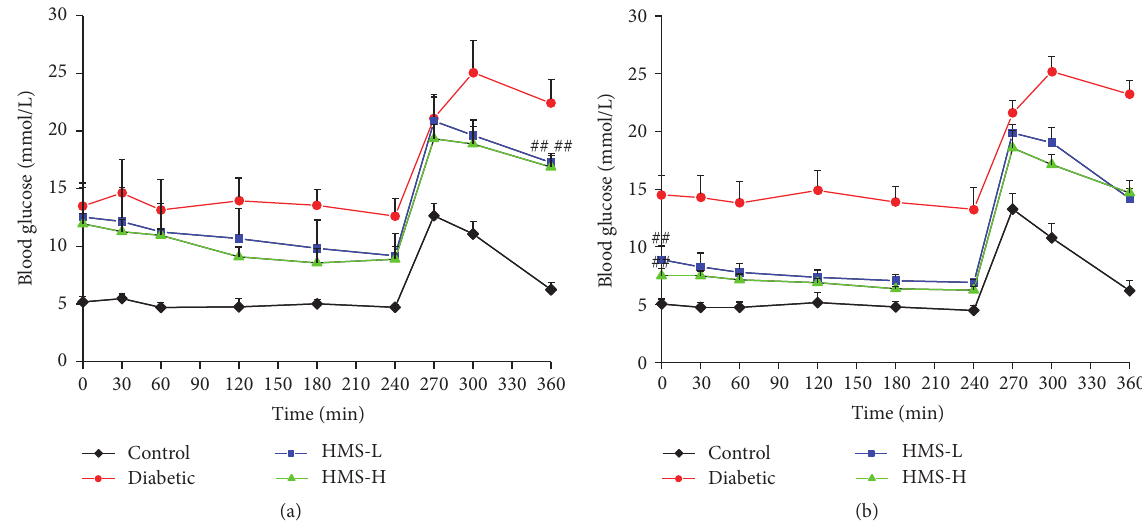
Figure 3: Effects of HMS5552 on oral drug tolerance 1 (a) and 27 days (b) after treatment with HMS5552. HMS-L group, low-dose (10mg/kg) HMS5552-treated diabetic group; HMS-H group, high-dose (30mg/kg) HMS5552-treated diabetic group. The data are expressed as the mean ± SD ( 𝑛 = 6 ). ## 𝑃 < 0.01 , compared with the diabetic